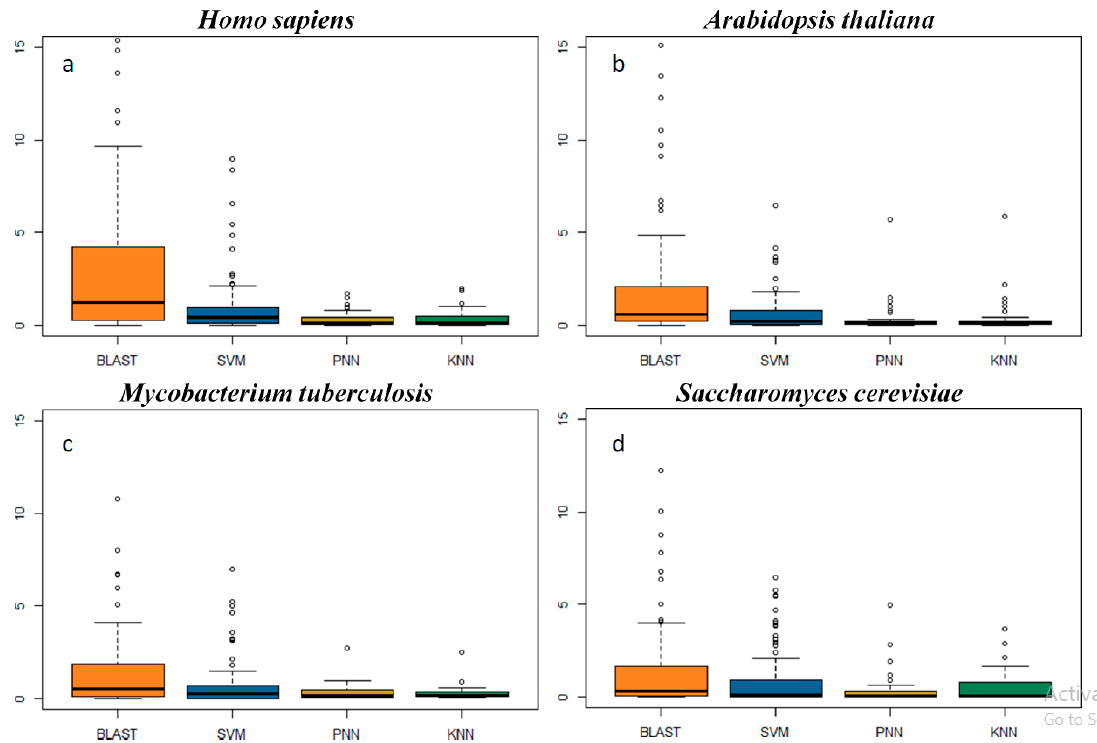
Figure 2. The false discovery rates reflected by the percentage of proteins identified from the genomes of ( a ) Homo sapiens , ( b ) Arabidopsis thaliana , ( c ) Saccharomyces cerevisiae and ( d ) Mycobacterium tuberculosis